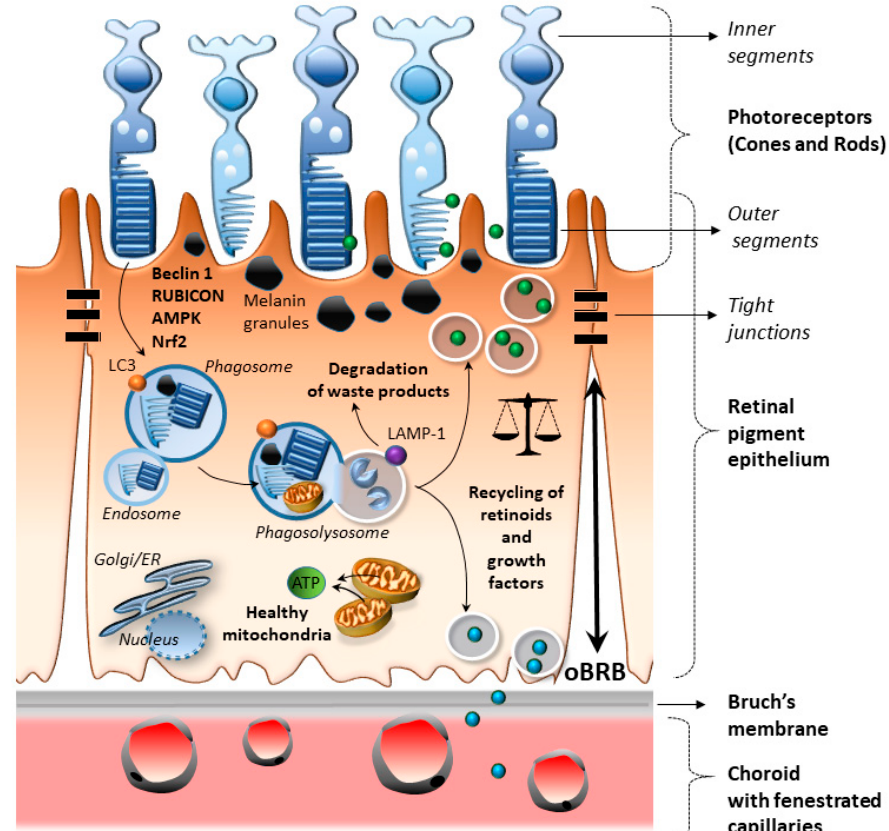
Figure 2. Autophagy grants retinal pigment epithelium (RPE) functions and homeostasis. Within the RPE, Beclin 1 / Rubicon, AMPK, and Nrf2 trigger heterophagy, which is the concerted action of LC3-associated autophagy and phagocytosis, which is crucial for the degradation and renewal of the outer segments of photoreceptors. A functional autophagy flux within RPE cells also grants redox and energy homeostasis by degrading altered mitochondria and oxidized material, including melanin granules, lipids, and lipofuscin. At the same time, some metabolic by-products, including retinoids and growth factors, are delivered to the photoreceptors or the inner choroid. A functional autophagy status goes along with the maintenance of the outer retinal–blood barrier integrity and a balanced polarity